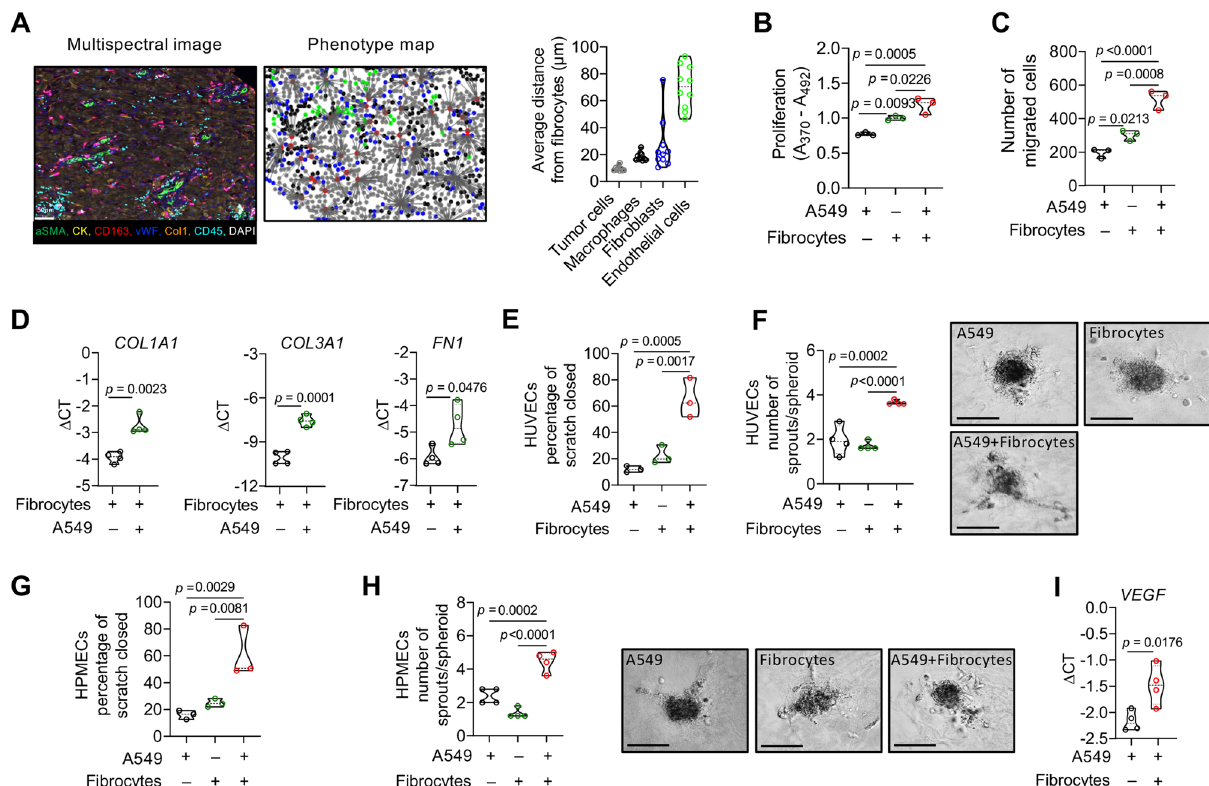
Fig. 6 | Cross-talk between fi brocytes and cancer cells promotes tumor cell proliferation, migration and endothelial cell sprouting. A Representative mul- tispectral image of cells in the human tumor microenvironment labeled with anti- bodies against pan-cytokeratin (CK), CD45, Col1, CD163, vWF, aSMA, and DAPI, n =10.Coloreddotsinthecellphenotypemapshows,cancercell(gray, n =52,867), macrophages (block, n =9468), endothelial cells (green, n =1376), fi brocytes (red, n =1174), and fi broblasts (blue, n =5766). Quanti fi cation of ( B ) proliferation ( n =3 independent experiments, 8 technical replicates) and ( C ) migration ( n =3 inde- pendent experiments, 3 technical replicates) of A549 in the presence of CM from A549 or fi brocytes or A549+ fi brocyte co-cultures. D COL1A1, COL3A1, and FN1 mRNA expression of fi brocytes or A549+ fi brocytes co-cultures, n =4. E Quanti fi cation of scratch assay in HUVECs in presence of CM from A549 or fi brocytes or A549+ fi brocyte co-cultures ( n =3 independent experiments, 3